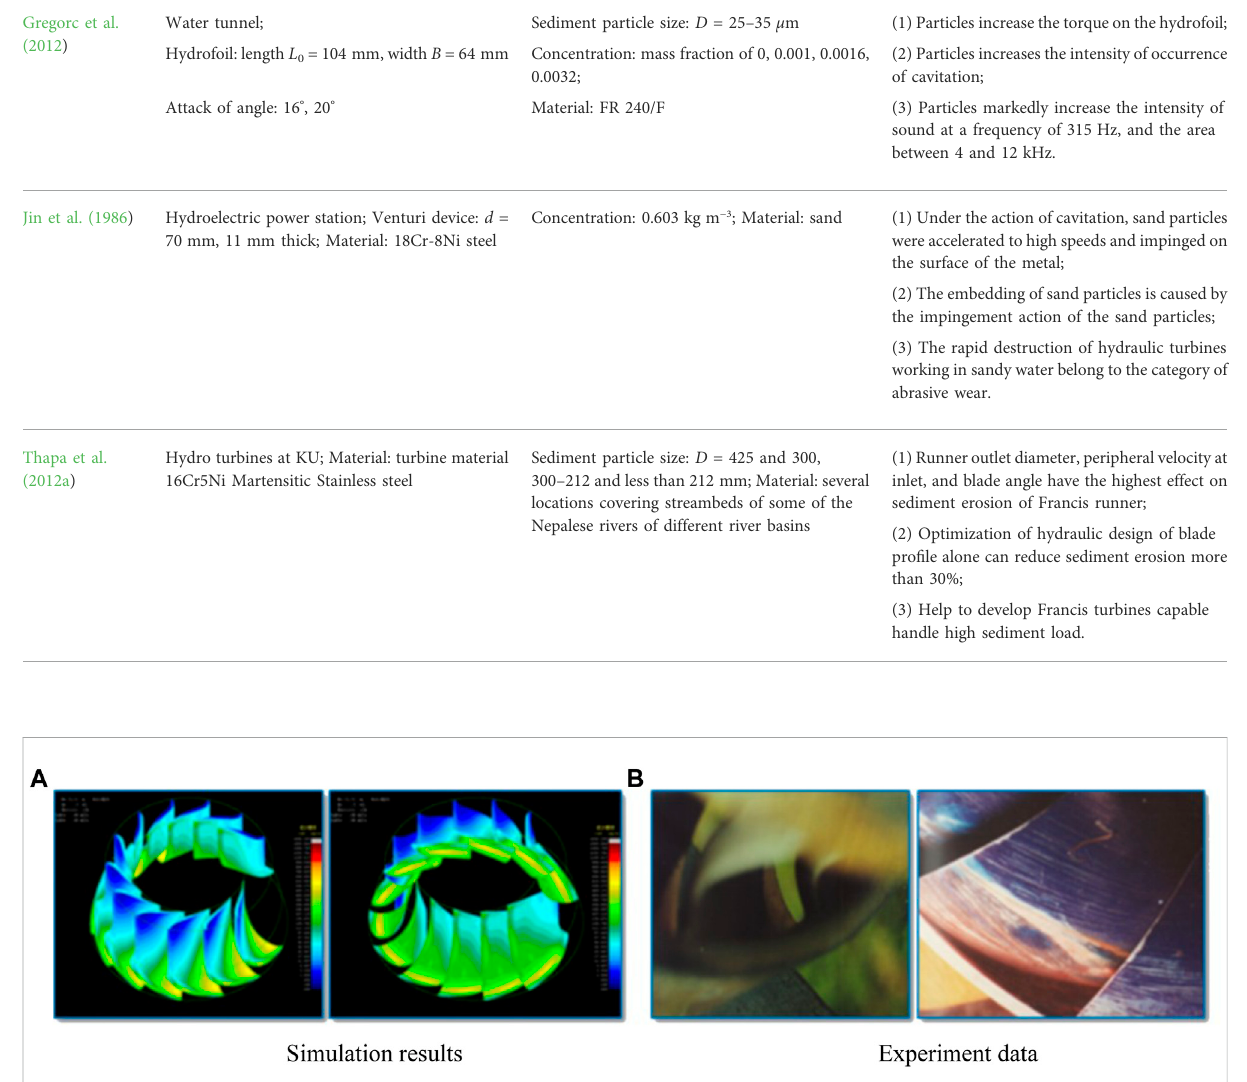
FIGURE 10 Comparisons of the erosion distribution on blades of turbines at Liujiaxia Hydropower station for (A) numerical results, and (B) experiment data (Lu et al.,